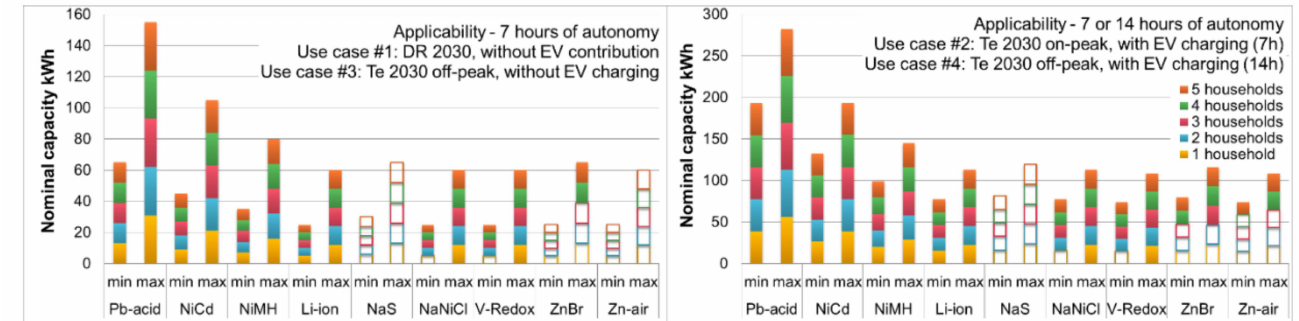
Figure 5. Nominal capacity and applicability of battery technologies in all case